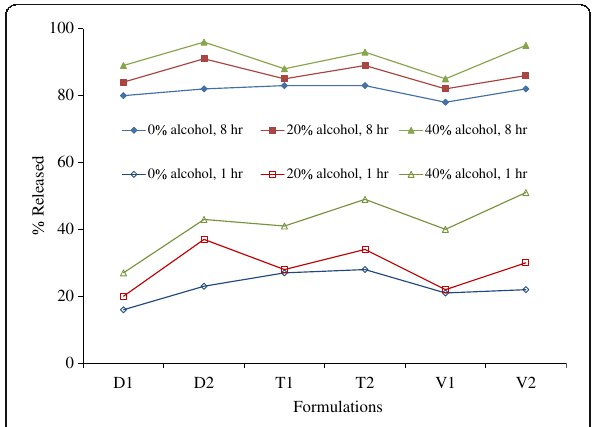
Fig. 27 Effect of alcohol on % drug released at 1 and 8 h from HPMC- based matrix tablets of diclofenac (D), tramadol (T) and venlafaxine (V) (data from reference (Avachat & Nandare 2014))